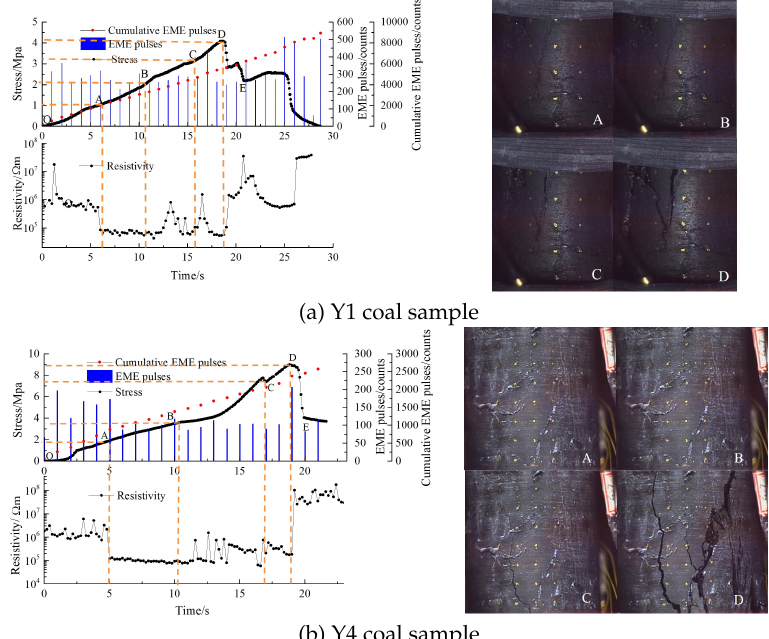
Fig. 3. Resistivity, electromagnetic radiation and crack propagation characteristics of Yuwu samples (A,B,C,D represents the different stress loading points of coal samples and the deformation and fracture diagrams of coal under the corresponding stress loading points)